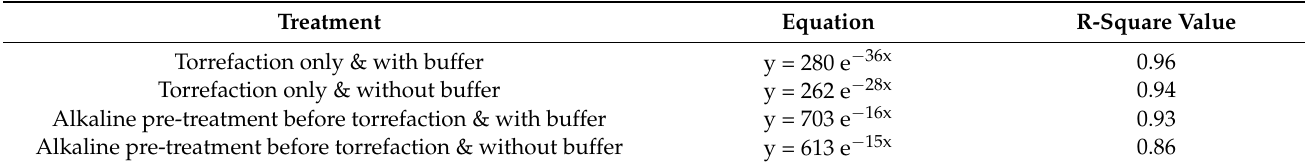
Table 3. Equations of exponential trendlines for glucose yield vs. torrefaction severity. (y = glucose yield, x = Torrefaction